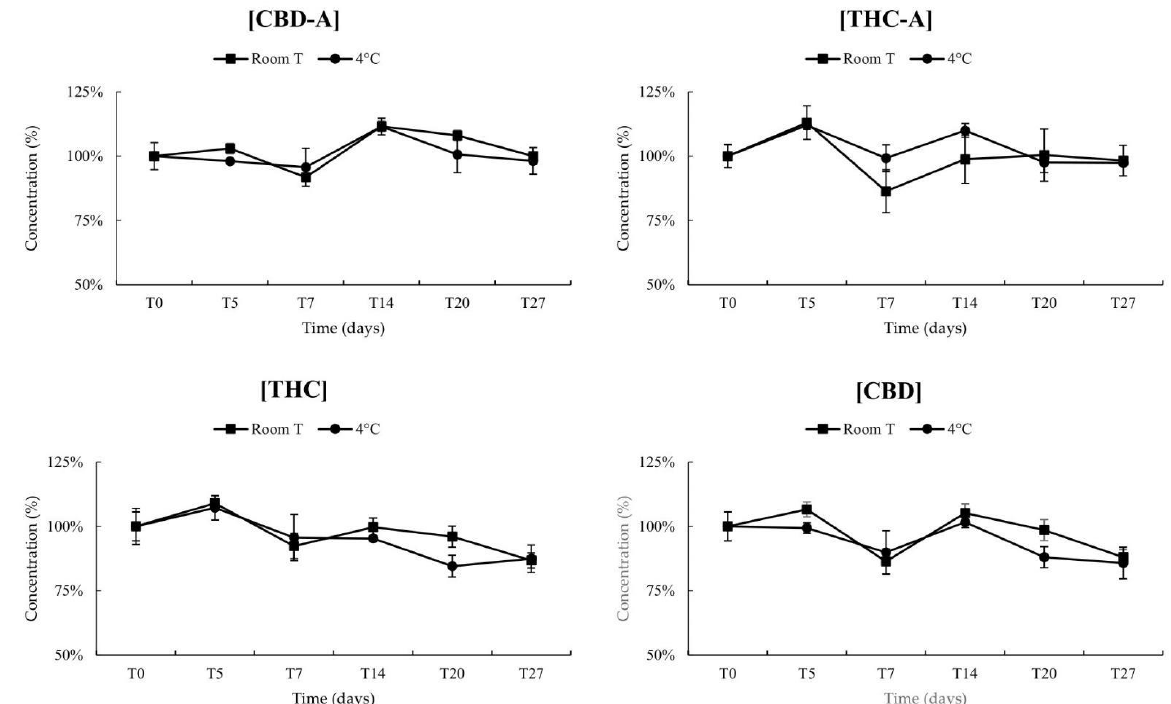
Figure 4. Stability of cannabinoids in FM2 at different temperatures and up to 27 days. The results are expressed as % initial concentration mean of three replicates. Bars indicate CV%.